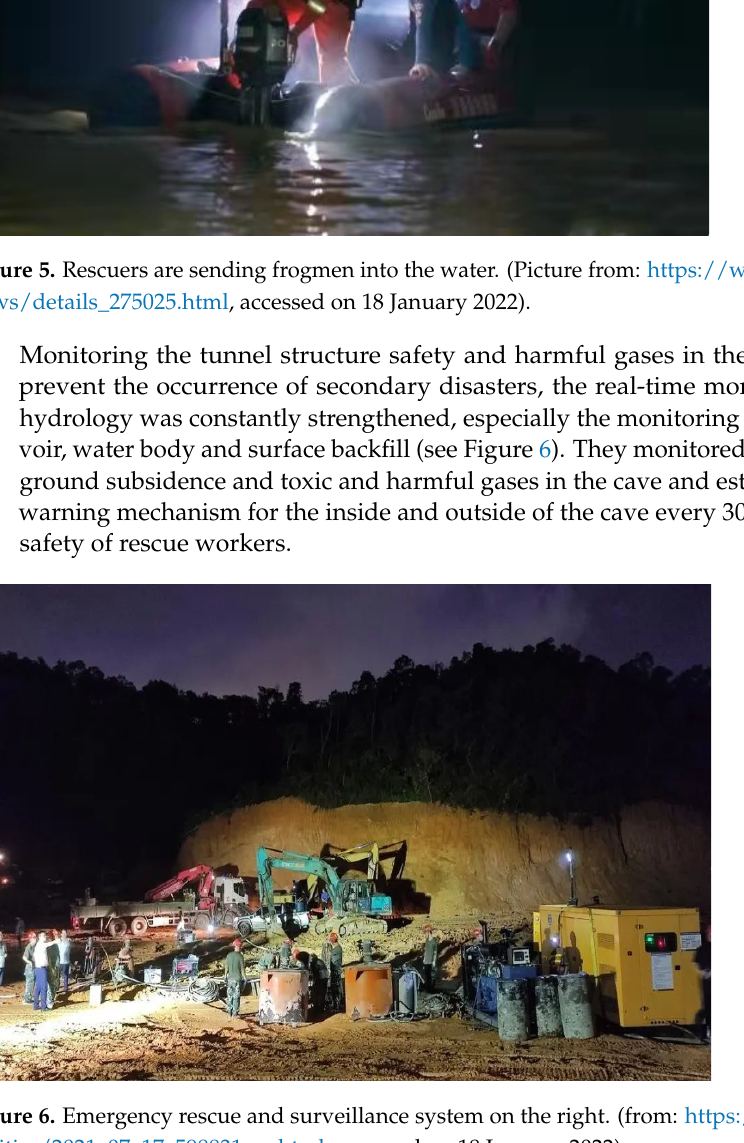
Figure 4. Rescue site cofferdam construction (Picture from: https://www.guancha.cn/poli-